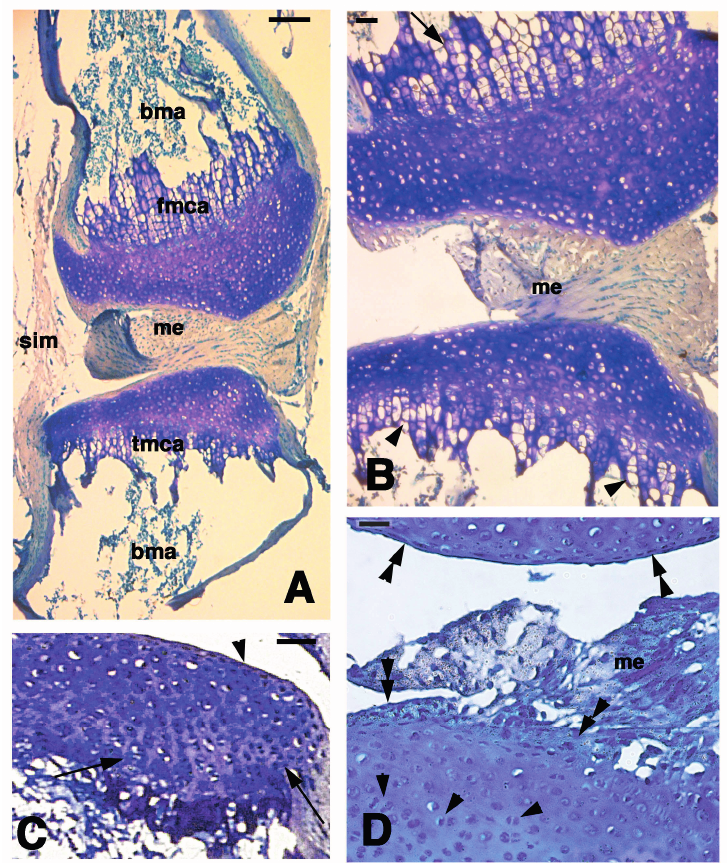
Figure 5. Histological aspects of the knee 21 days after the lesion. ( A ) General view of a case showing the apposed cartilaginous epiphyses with the meniscus. Bar, 100 µm; ( B ) Detail on the highly cellularized, regenerated articular cartilages where a metaphyseal plate is formed in both femur (top, arrow) and tibia (bottom, arrowheads). Bar, 25 µm; ( C ) Other case with regenerated articular cartilage containing flat superficial chondrocytes (arrowhead) and the beginning of formation of piled chondrocytes (arrows) in the forming metaphyseal cartilage. Bar, 50 µm; ( D ) detail of highly cellularized cartilage with numerous isogenous groups (arrowheads). Bar, 25 µm. Legends : bma, bone marrow; fmca, femur metaphyseal cartilage; me, meniscus; tmca, tibia cartilaginous